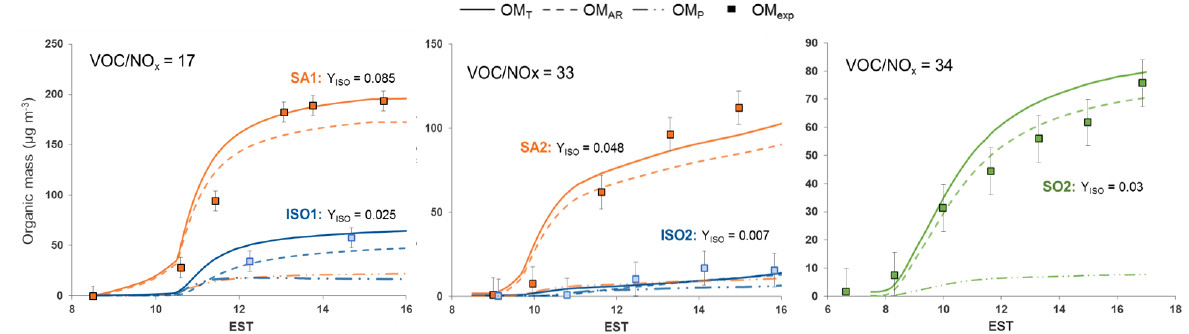
Figure 3. Time profiles of the experimentally measured and simulated SOA mass concentrations resulting from the photooxidation of isoprene. Data from experiments performed in the absence of inorganic seed are shown in blue, in the presence of sulfuric acid in orange, and in the presence of inorganic seed generated from SO 2 photooxidation in green. Solid, dashed and dashed-dotted lines represent the simulated total organic mass (OM T ) , organic mass from aerosol phase reactions (OM AR ) and organic mass from partitioning (OM P ) , respectively. The experimentally measured organic mass (OM exp ) is shown with square markers and is corrected for particle wall loss. The VOC / NO x ratios (ppbCppb − 1 ) are shown for each